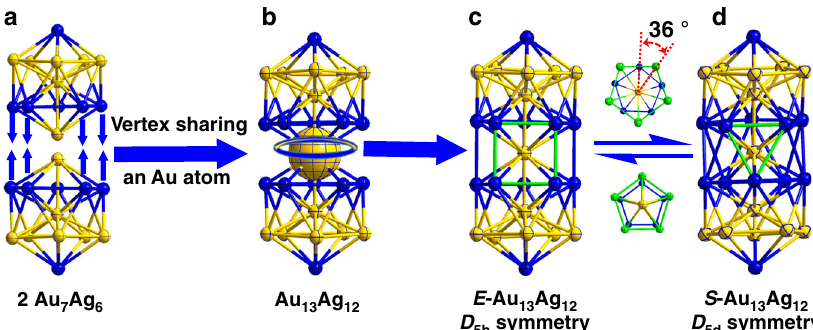
Fig. 3 Con fi guration of the Au 13 Ag 12 nanocluster. a , b Two icosahedral Au 7 Ag 6 units share one common vertex of Au to form the Au 13 Ag 12 nanocluster. c Metal con fi guration of E -isomer. d Metal con fi guration of S -isomer. Color code: Au: yellow; Ag: blue. Other atoms are omitted for clarity. (i.e., E -Au 13 Ag 12 , Fig. 3c), whereas at 25 °C the two Au 7 Ag 6 units rotate by about 36° to form a staggered ( S ) con fi guration with D 5d symmetry ( S -Au 13 Ag 12 , Fig. 3d). We note that, at the lower temperature ( − 10 °C), the Au 13 Ag 12 nanocluster prefers to adapt the con fi guration with a higher symmetry. The six chloride ligands — which bridge the two Au 7 Ag 6 units — serve as the “ belt ” to drive the rotamerization, Fig. 4. In the E -Au 13 Ag 12 isomer, there are fi ve Cl ligands with each being bonded with two silver atoms (d-mode). For the same isomer, there is also a Cl ligand that is bonded with four silver atoms (q-mode). In the S -Au 13 Ag 12 isomer, four Cl ligands are Fig. 4 Structures of E - and S -Au 13 Ag 12 isomers from the top view. Doubly in the d-mode bonding, and two Cl ligands are each bonded with (d), triply (t), and quadruply (q) binding patterns of six equatorial Cl ligands three silver atoms (t-mode). bridging the two icosahedra. Color codes: Au: yellow; Ag: blue; Cl: